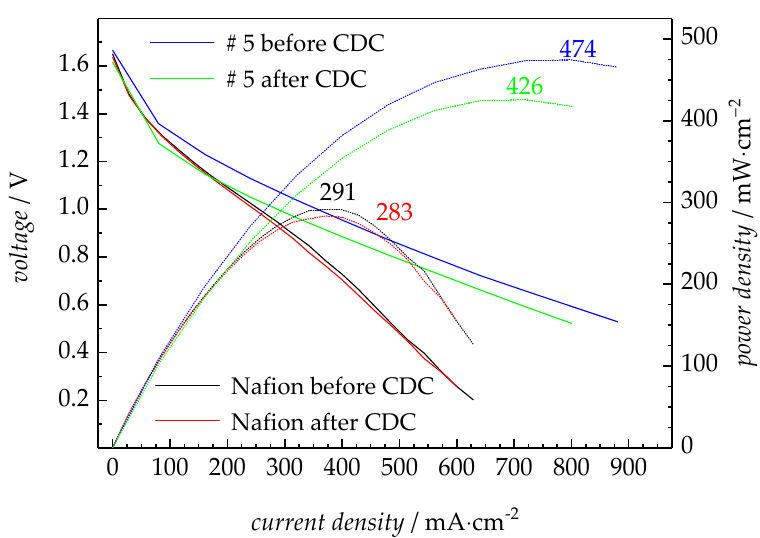
Figure 8. Polarization curves of sample #5 and Nafion 117. The numbers indicate the power density with the units of mW ∙ cm ‒ 2 .